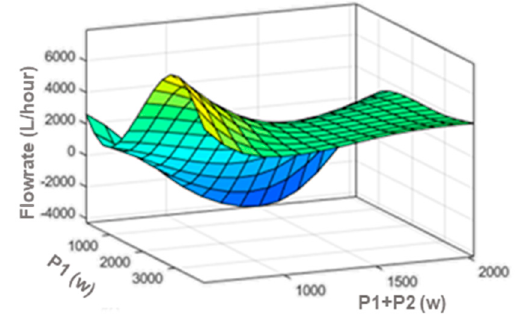
Figure 9. Anfis surface output.